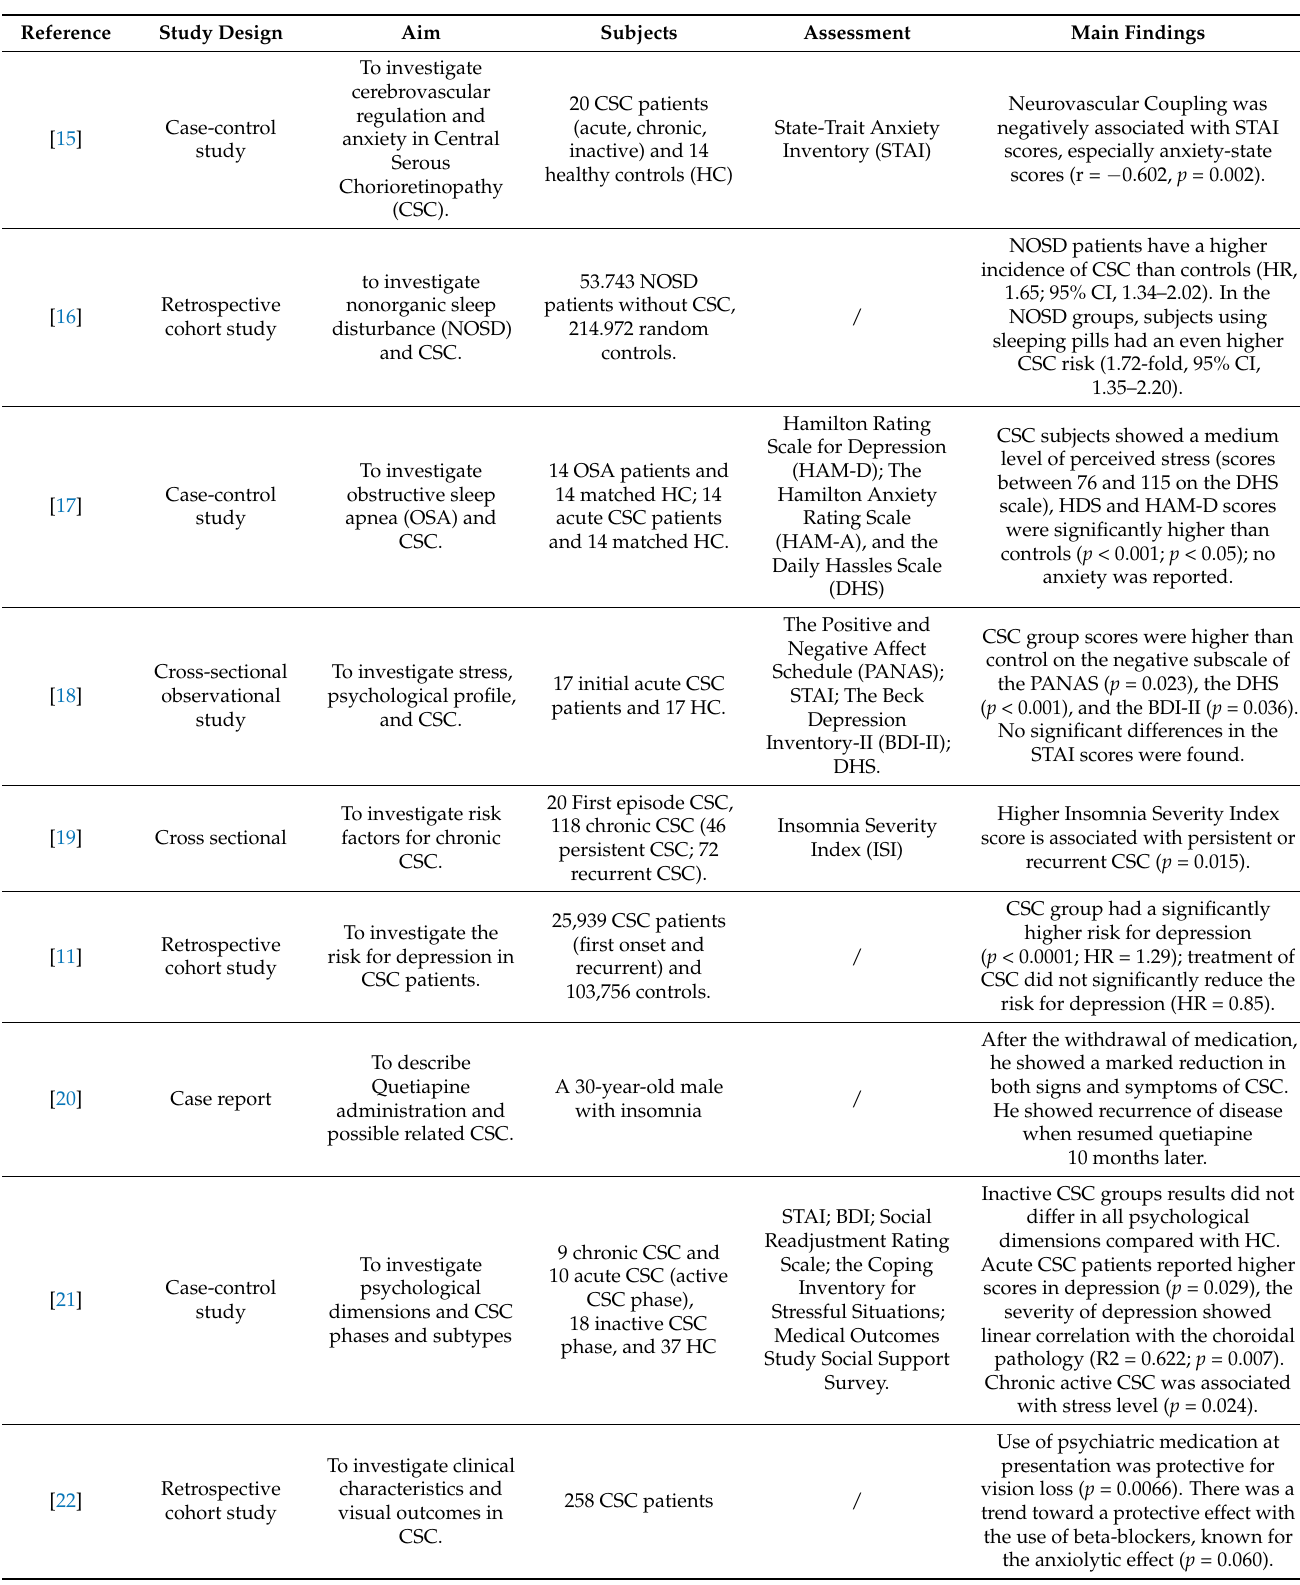
Table 2. Selected manuscripts evaluating psychiatric factors in Central serous chorioretinopathy (CSC)